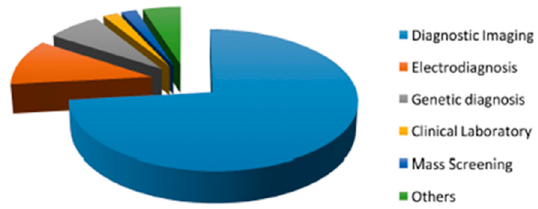
Figure 8. Data sources used for machine learning